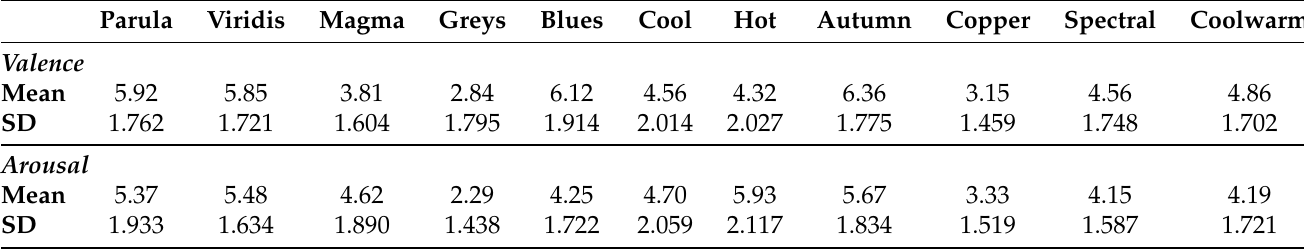
Figure 10. The synthetic distribution of the 11 colomaps regarding the affect evoked in the valence– arousal coordinate system. The white dots represent the exact locations of the colormaps. Table 2. Summary of the mean values and standard deviations of the affective responses obtained in crowdsourced study Part I with 99.5%